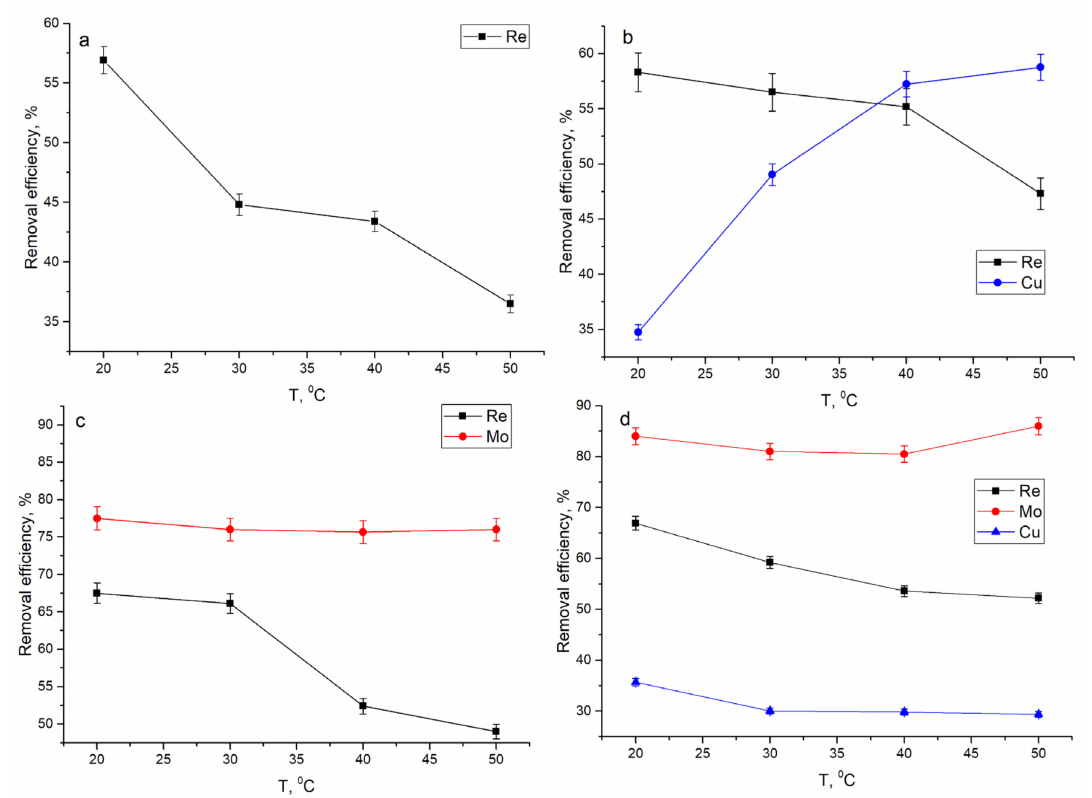
Figure 3. Effect of temperature on metal ions removal from analyzed systems: ( a ) Re, ( b ) Re-Cu, ( c ) Re-Mo, and ( d ) Re-Mo-Cu.